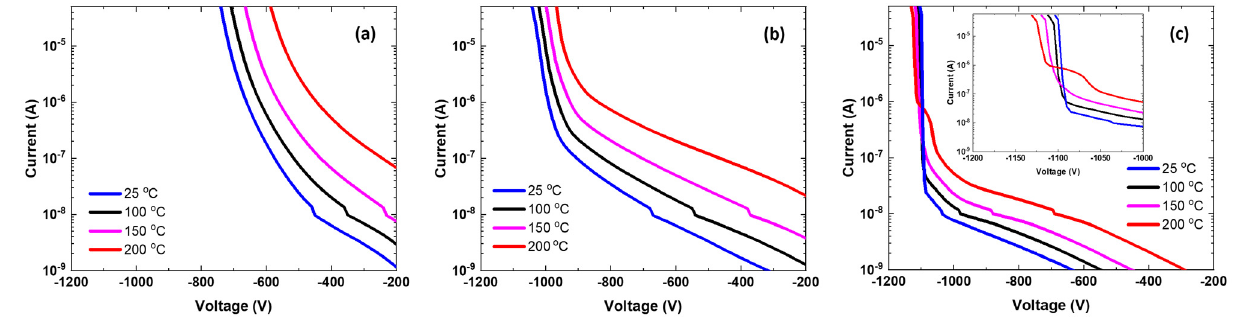
Figure 2. Reverse sweep measurements at different temperatures for the three samples in this work: ( a ) 500 nm anode; ( b ) 400 nm anode; ( c ) 300 nm Anode.